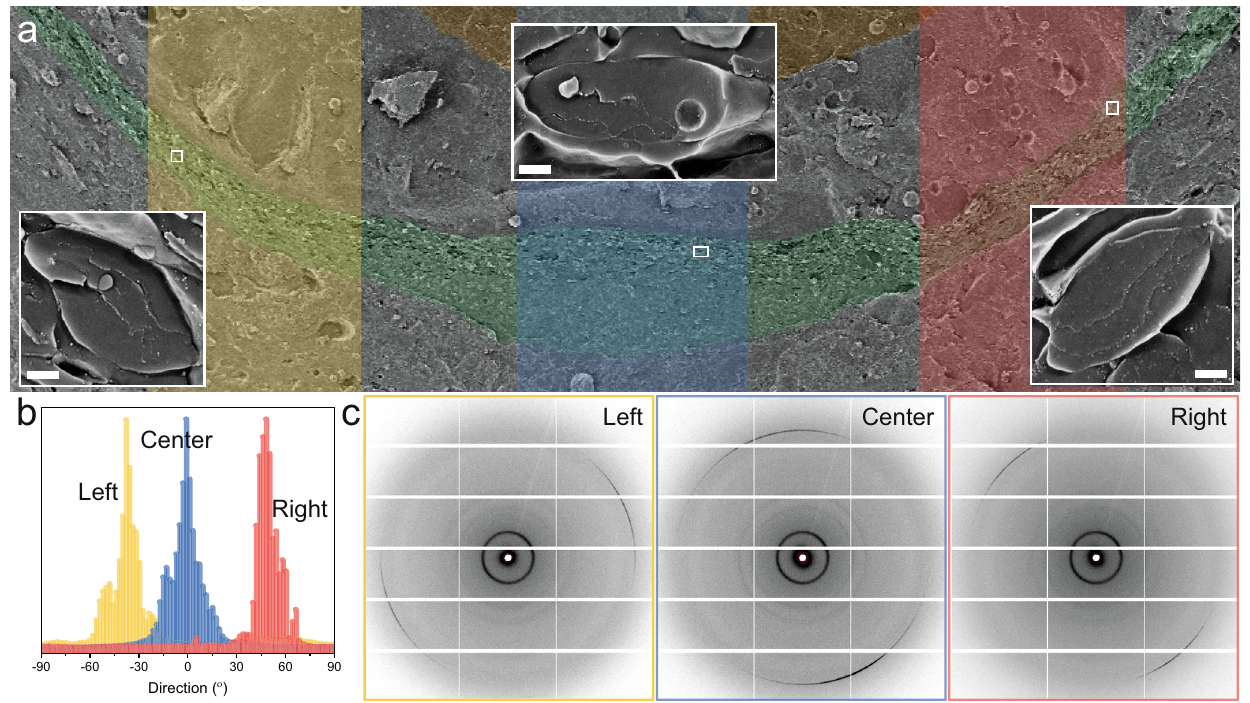
Fig.5|Intraluminalsheetscontrolcrystalorientation.a Lowmagni fi cationcryo- SEM image of the mirror in a juvenile scallop eye (Fig. 1b). Inserts: representative cryo-SEM images of iridosomes from the regions of interest, demonstrating the orientation of the sheets follows the curvature of the mirror. b Histograms repre- senting the directionality of the templating sheets in the juvenile, from the three